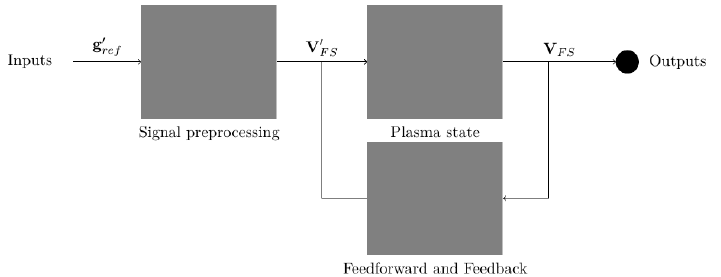
Figure 4. Block scheme of the plasma shape LQG control